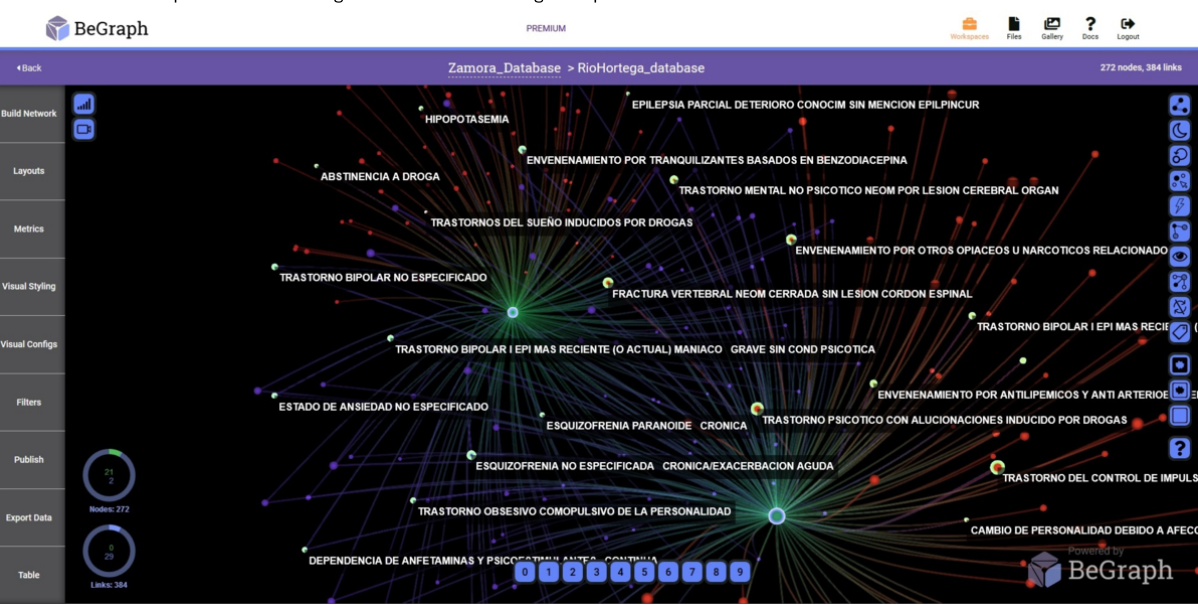
Figure 6. Network with prevalent diseases-gender in the Rio Hortega Hospital of Valladolid.